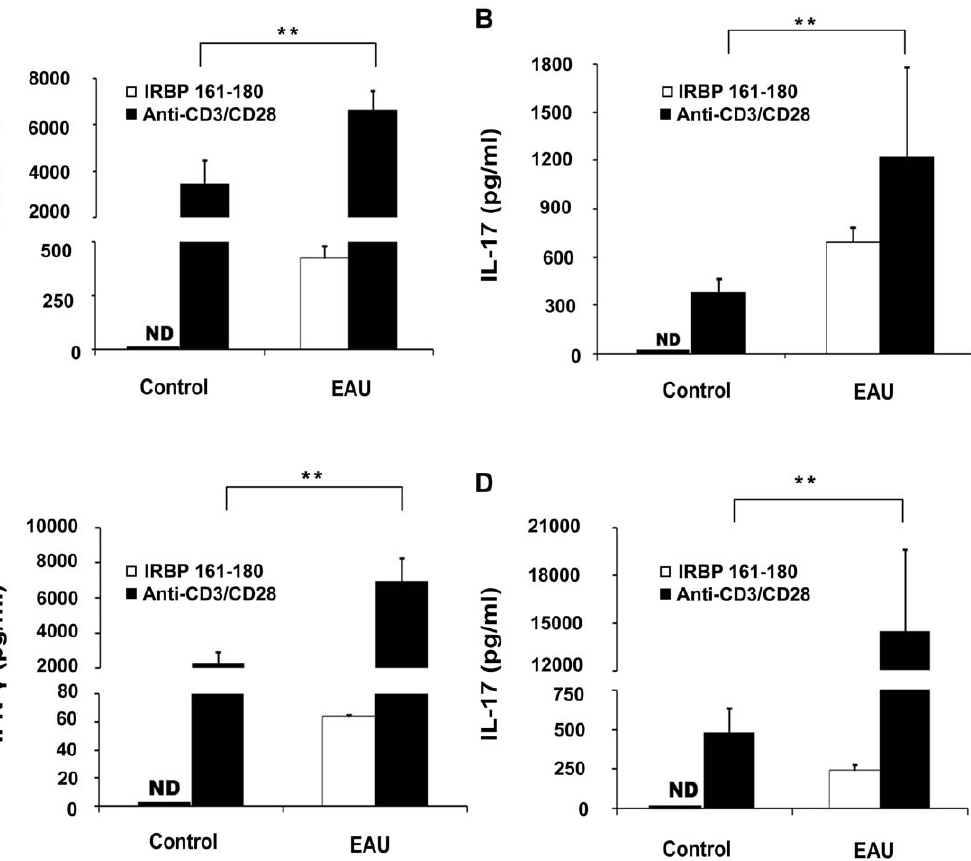
Figure 2. The expression of IFN- c and IL-17 in EAU mice and control mice. Splenocytes (A and B) and DLN cells (C and D), obtained from EAU mice or control mice on day 13, were activated with IRBP 161-180 (20 m g/ml) or anti-CD3 and anti-CD28 (1 m g/ml) for 72 hours. IFN- c and IL-17 were analyzed by ELISA. Data are representative of three independent experiments. **p , 0.01, ND= not detected.